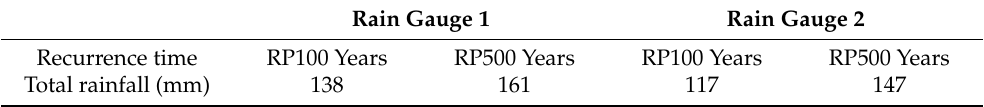
Figure 8. Areas of influence of the rainfall stations in the modeling domain of industrial park. Table 7. Design storms for hydrological-hydrodynamic